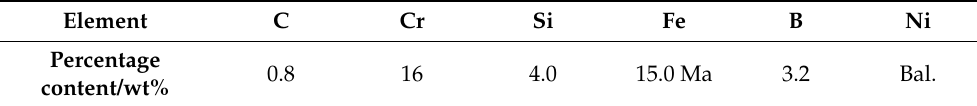
Table 2. Chemical composition of Ni60 alloy